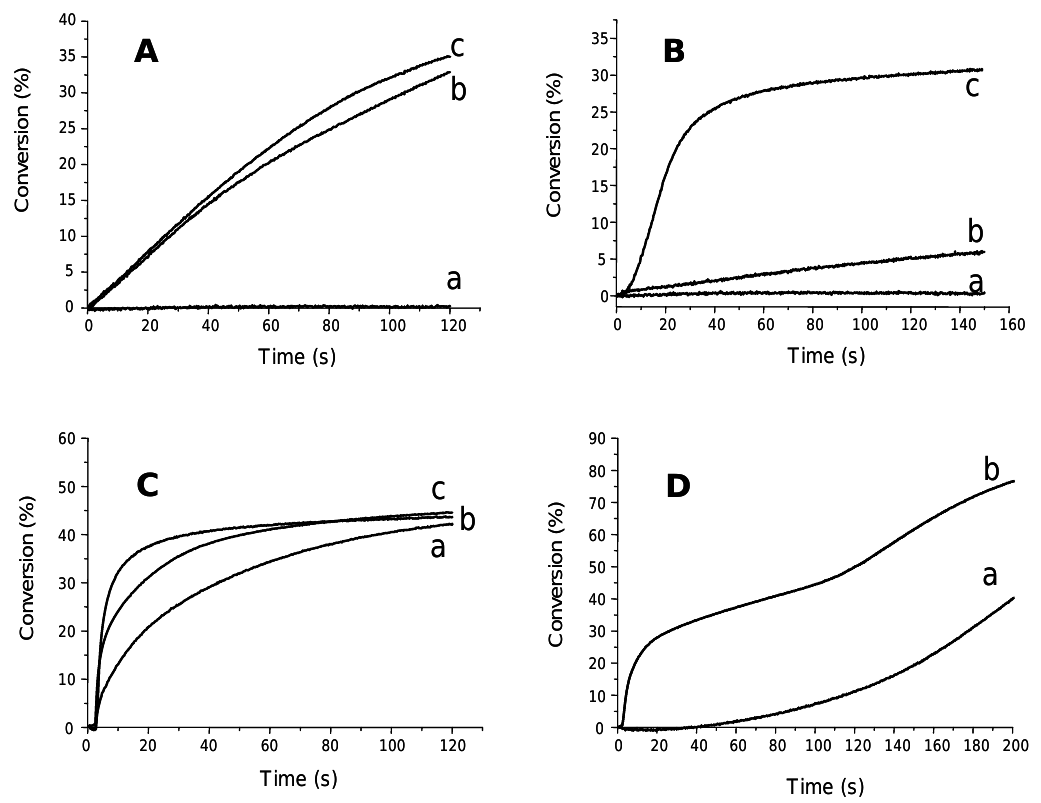
Figure 2. Photopolymerization profiles of TMPTA under air. Upon Xenon lamp